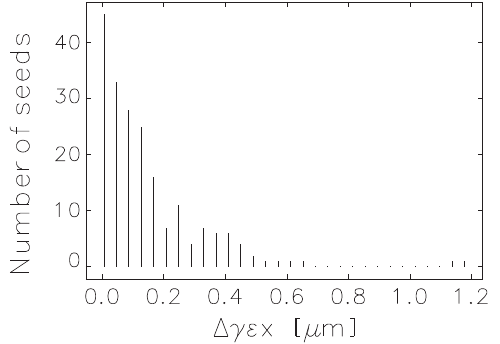
FIG. 12. Horizontal projected normalised emittance growth from misalignment of the rf structures and quadrupole magnets in the linac, observed at linac end. One-to-one steering is